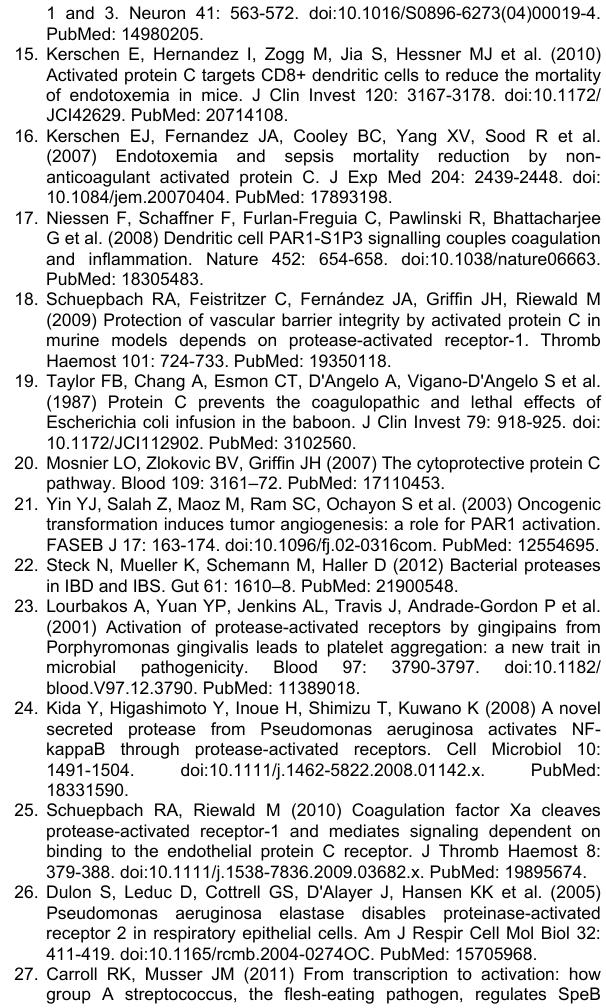
Figure S1. No cleavage of AP-PAR-1 construct outside PAR-1’s N-terminus. 293T cells transiently expressing alkaline phosphatase and FLAG-tagged PAR-1 were incubated with bacterial supernatants, thrombin (IIa; 1nM) or buffer. Supernatants and cells were then separately analysed by Western blot for N-terminal PAR-1 cleavage. Representative experiment out of 3. Figure S2. SpeB column purified from GAS supernatants and commercial SpeB cleaved PAR-1 with comparable efficiency. transiently phosphatase-tagged PAR-1 were incubated with indicated amounts of column purified (pSpeB) and commercial SpeB and cleavage of PAR-1 reporter constructs was quantified.